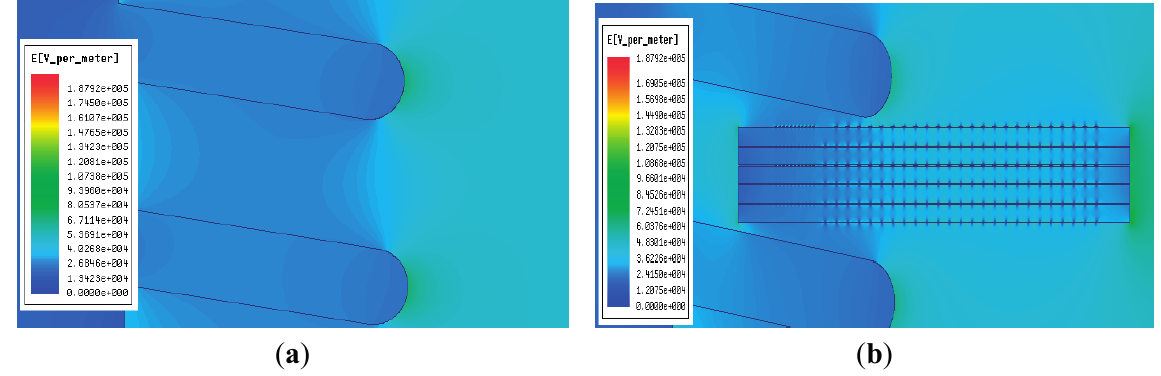
Figure 10. Influence of the voltage sensor on the electric field to be measured. ( a ) Electric field distribution before introducing the voltage sensor; ( b ) Electric field distribution after introducing the voltage sensor. Table 1. Calculated value of electric field intensity for different voltage values. Value of Electric Field Voltage (kV)